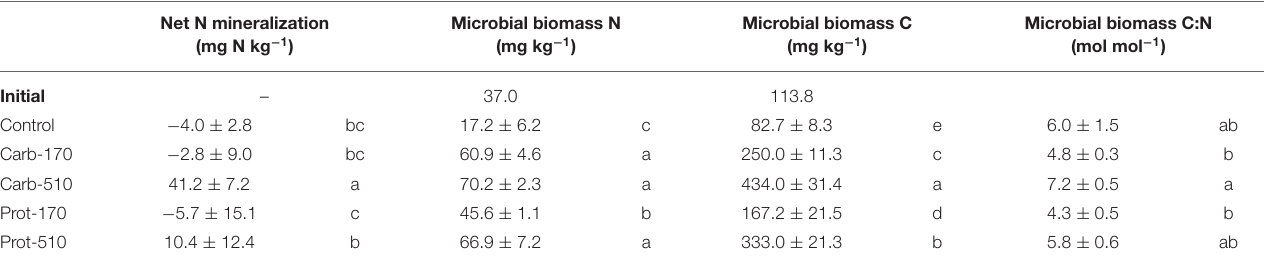
Different letters in one column indicate a significant difference between